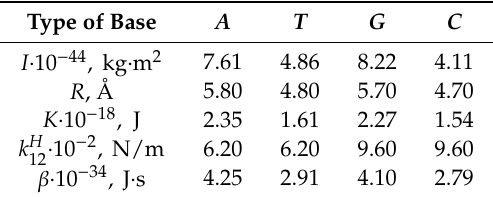
Table 1. Equation coefficients (1 ′ )–(2 ‴ ).